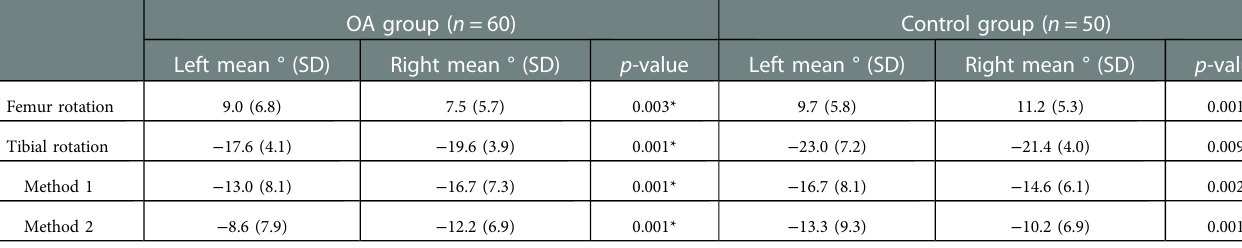
TABLE 1 Results of bilateral measurements separately shown for OA and control subjects.